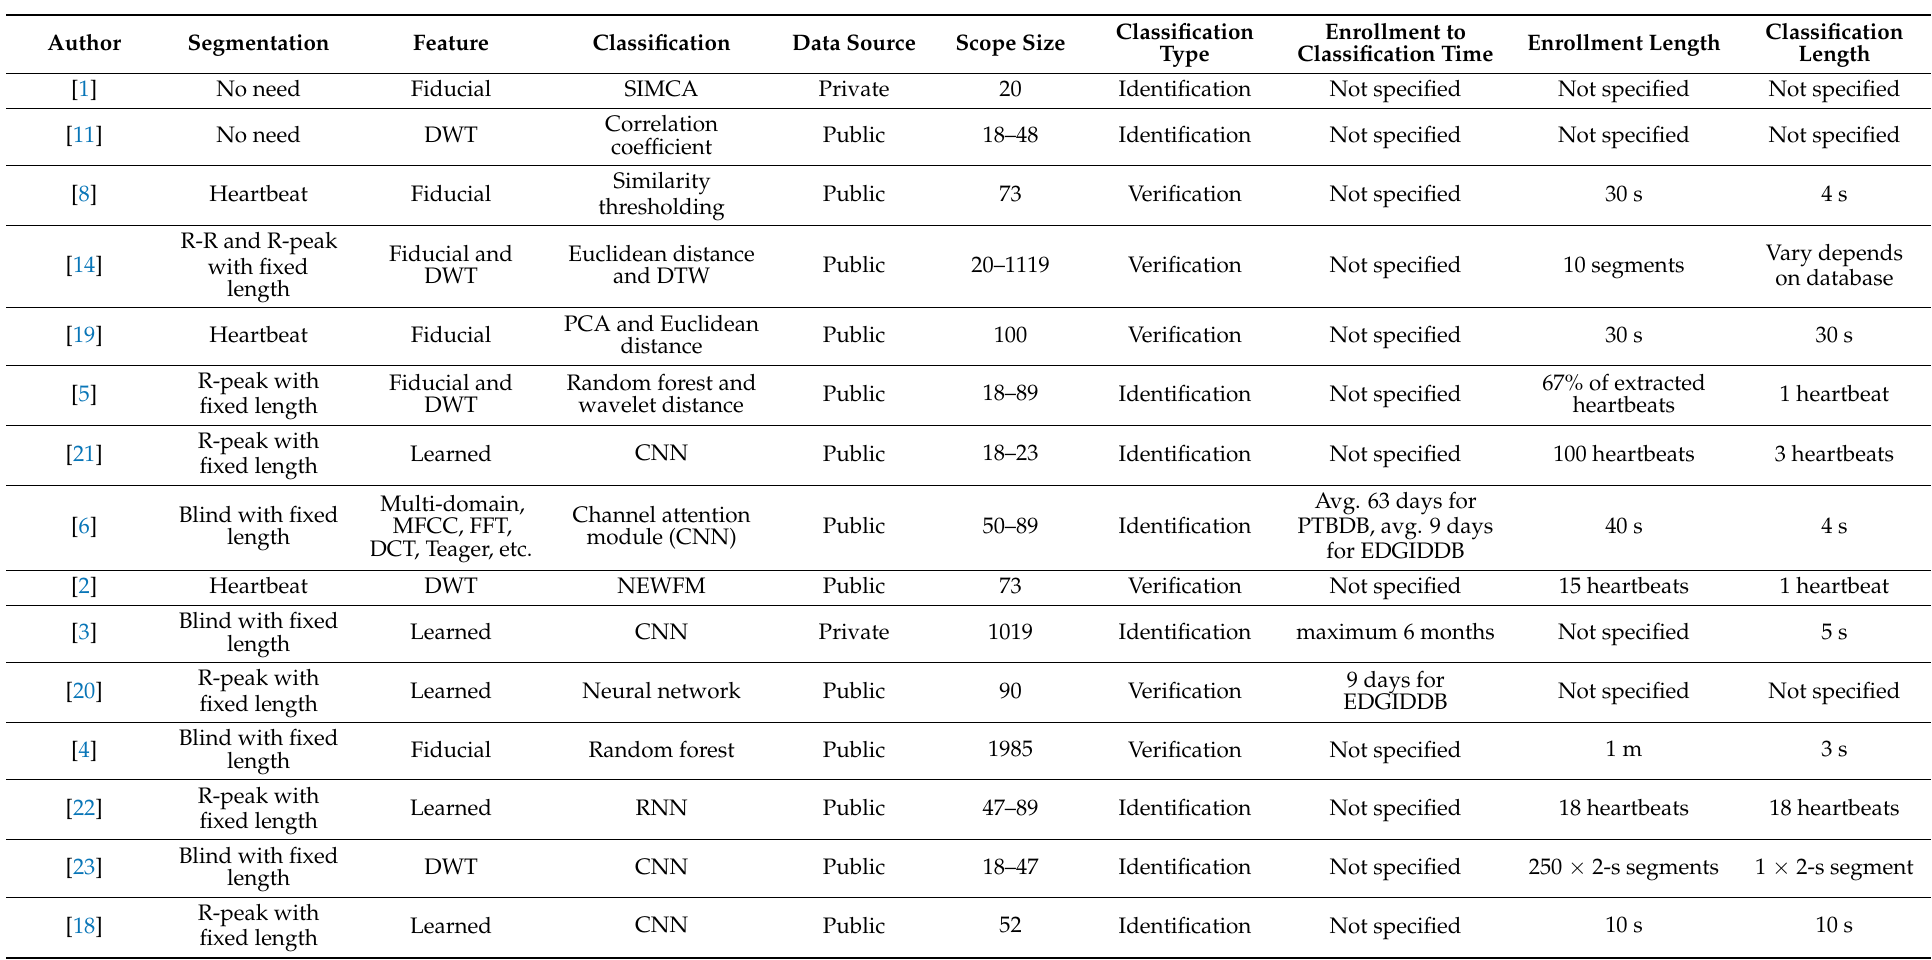
Table 3. A summary of the related